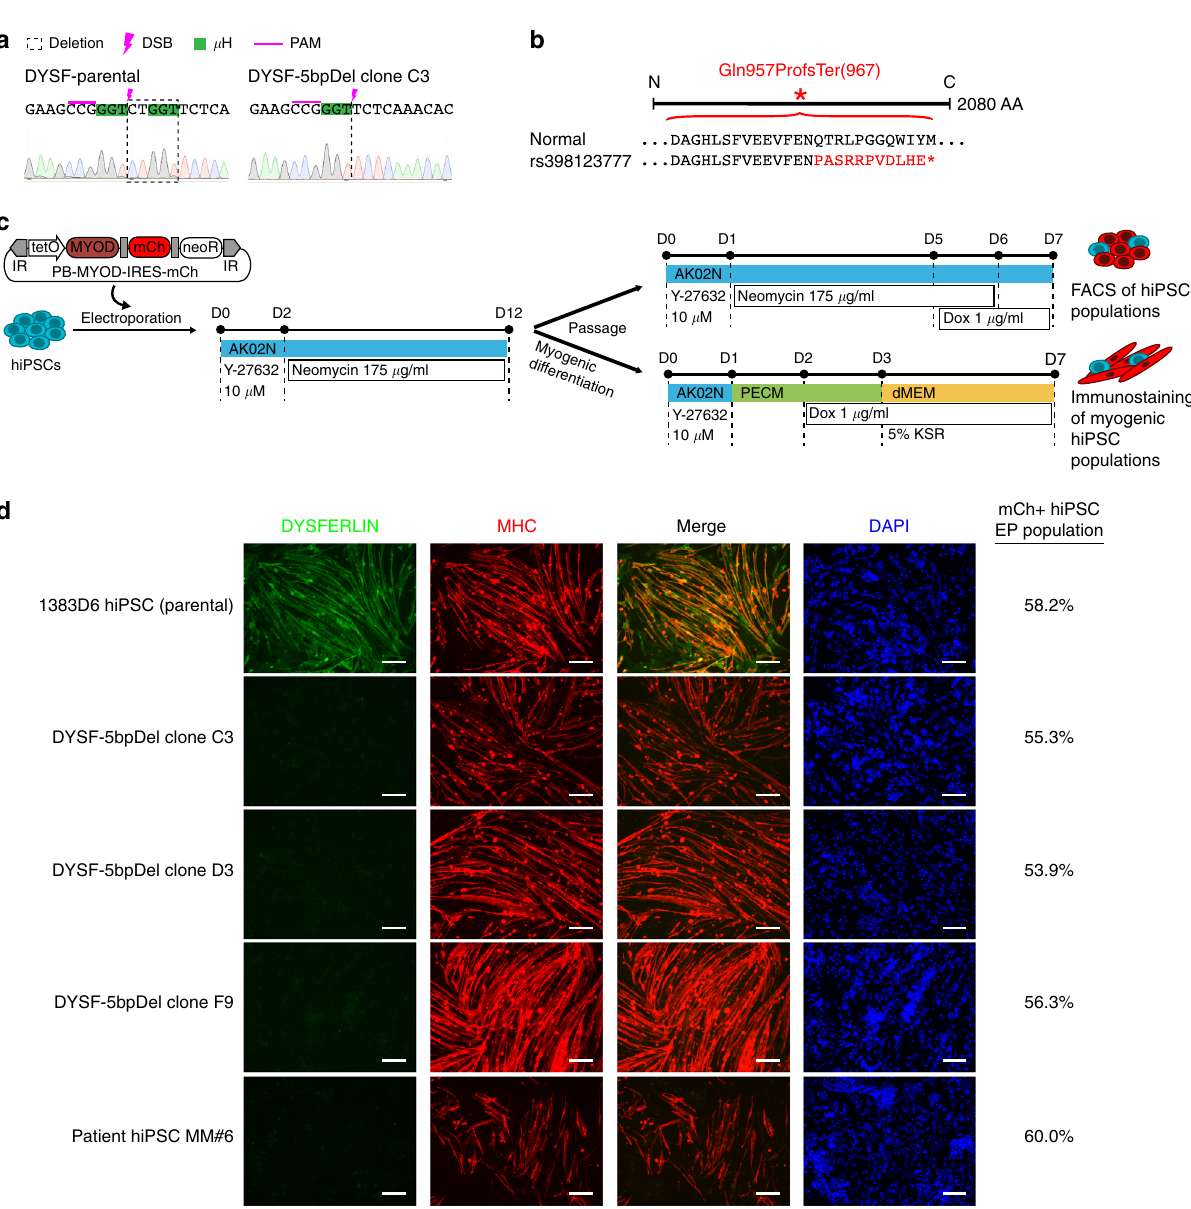
Fig. 3 @Target variant associated with muscular dystrophy created by MMEJ recapitulates DYSFERLIN loss-of-function. a Sequence veri fi cation of a precise 5bp deletion mutation in DYSF. Deletion (dotted line), DSB location (pink bolt), µ H (green), SpCas9 PAM (underline). b Altered protein sequence of DYSFERLIN caused by the 5 bp deletion mutation. c Schematic of the experimental procedure to induce myogenic differentiation in hiPSCs by overexpression of MYOD from a piggyBac transposon. Differentiation day (D). d Immunostaining for DYSFERLIN and MHC in differentiated hiPSC populations. Comparison of the isogenic parental cell line, three derived clones carrying the disease mutation and a muscular dystrophy patient derived hiPSC cell line. Scale bar indicates 100 µ m; ratio of mCherry + cells measured by FACS in corresponding electroporated (EP) hiPSC populations indicated on the